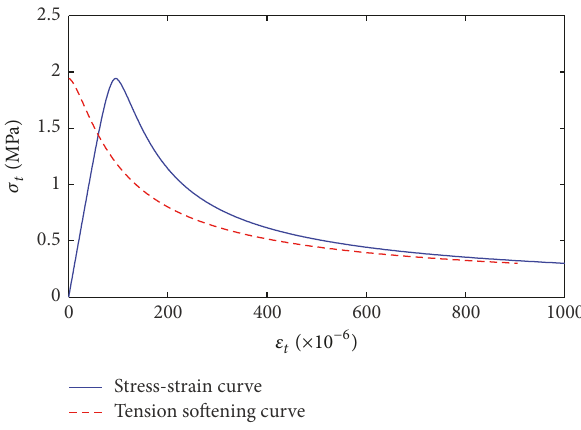
Figure 6: Total stress-strain relation under uniaxial tension and tension softening curve of